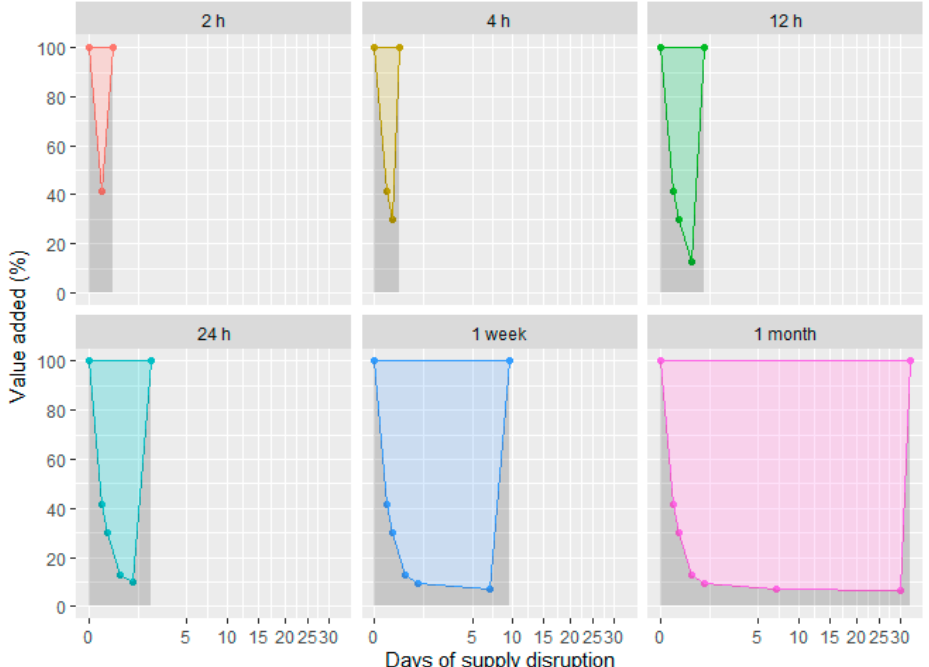
Figure 2. Schematic description of changes in value added over time during and after water supply disruption events of different lengths. A value added of 100% represents the baseline level of normal business activity. The colorful areas thus represent the value added lost, and the dark gray areas represent the maintained value added from disruption start to the end of recovery.